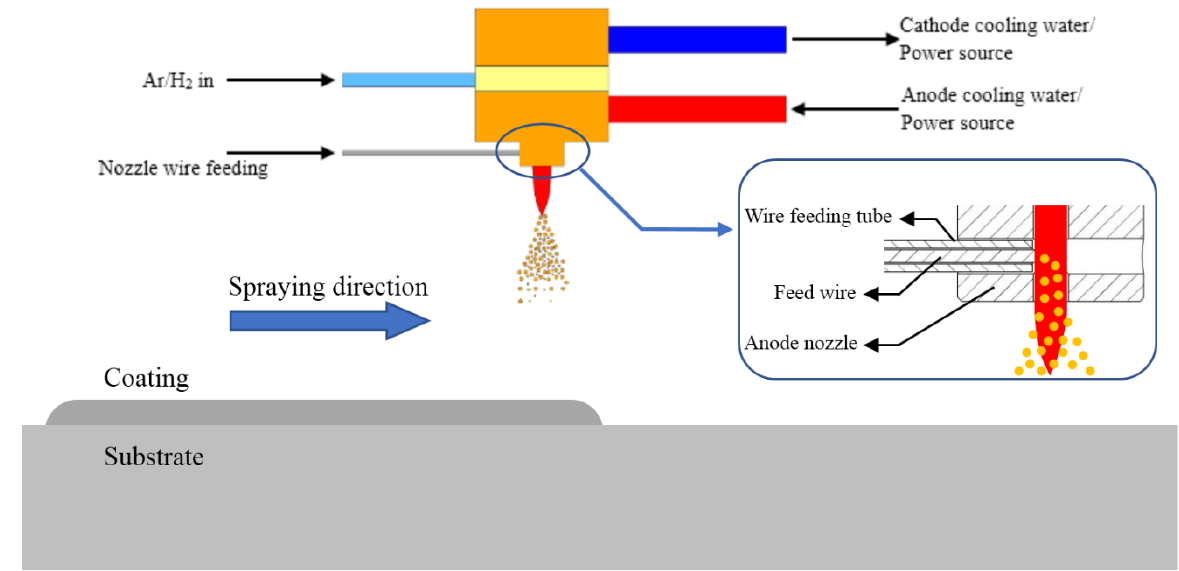
Figure 3. Schematic of plasma spraying with wire feeding. Table 1. Plasma spraying